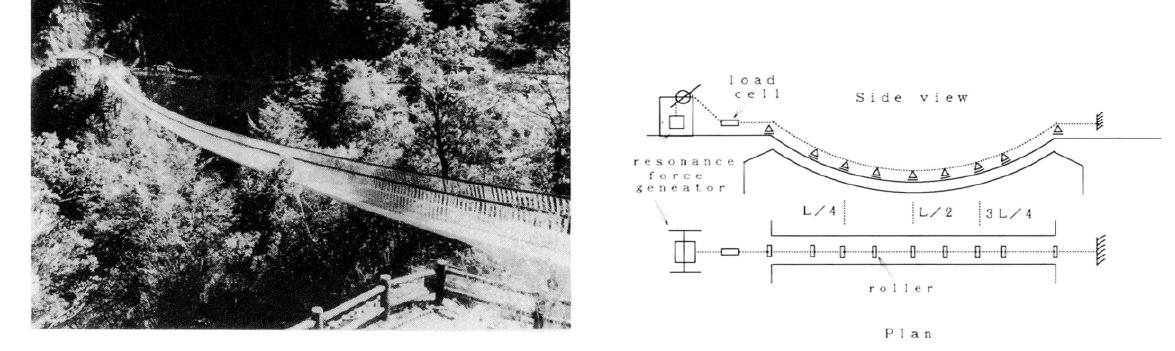
FIGURE 6 Field tests